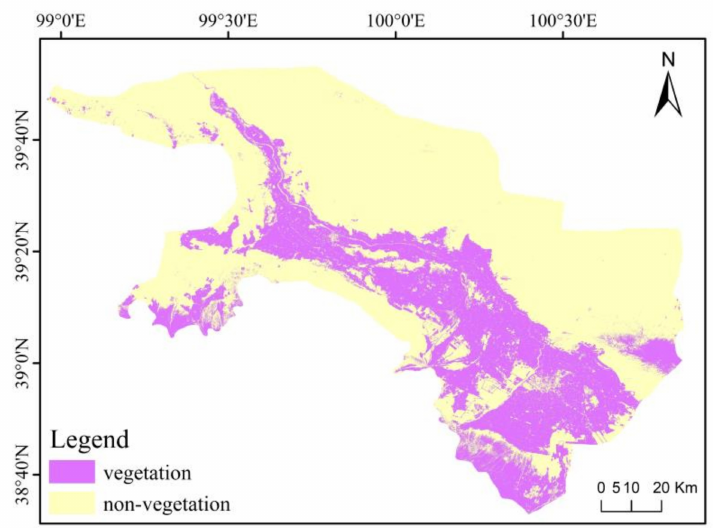
Figure 3. The vegetation extraction result in the study area. “Yellow” represents the non-vegetation area, “purple” represents the vegetation area, and then the maize planting area will be further extracted in the vegetation